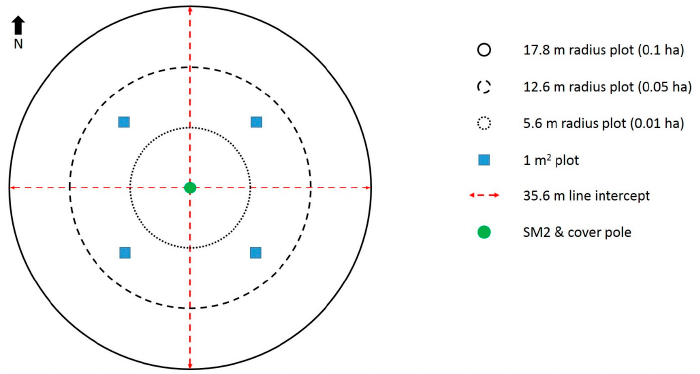
Figure 1. A 0.1 ha circular nested plot design used to study forest composition and structure effects on Neotropical aerial insectivorous bats in the Chiquibul Forest Reserve (CFR), Belize, Central America, in summer 2014. Plots, lines, and poles sampled different strata and types of cover, and SM2s sampled bat richness and activity.